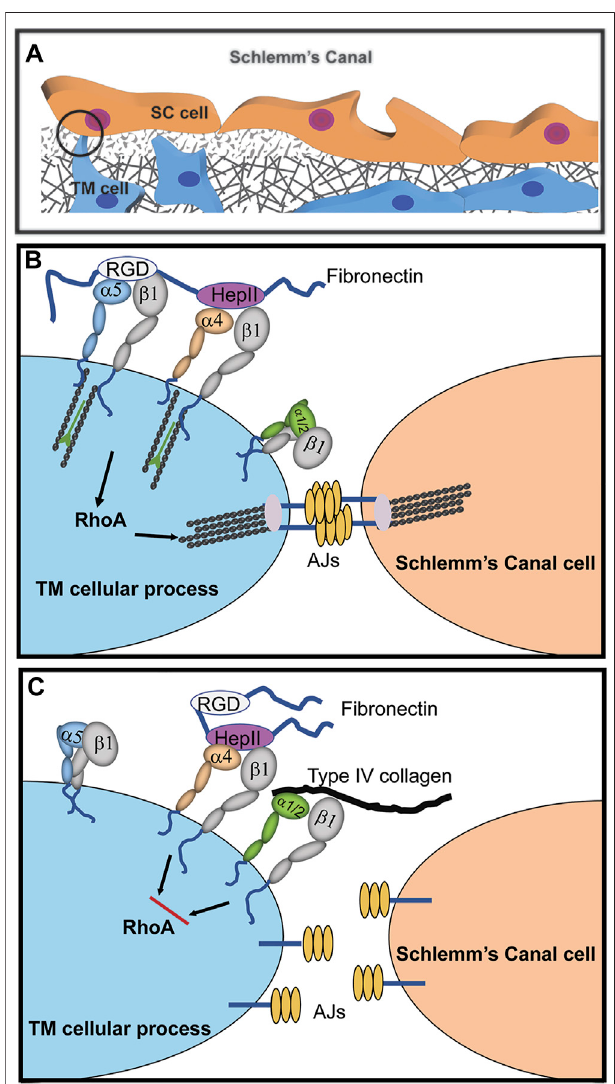
FIGURE 2 | Cooperative signaling with α 4 β 1 integrin controls assembly ofadherensjunctions(AJs). (A) Cadherin-containing AJs arelikelytobefound in the cellular processes connecting juxtacanalicular trabecular meshwork (JCT) and SC cells as well as in cellular processes connecting JCT cells to each other and with JCT cells connected to the cells lining the trabecular beams of the meshwork (Johnstone et al., 2021). (B) Fibronectin in the ECM promotes cooperative signaling between α 4 β 1 and α 5 β 1 integrins that activates RhoA-mediated stress fi ber formation. Crosstalk between this integrinsignalingcomplexandcadherinsinAJsstabilizescell-cellinteractions. (C) The presence of collagen in the ECM binding to either α 1 β 1 or α 2 β 1 integrins disrupts α 4 β 1 integrin signaling with α 5 β 1 integrin. This creates an α 1/ α 2 β 1 and α 4 β 1 integrin complex that inhibits RhoA activity, thus causing a disruption in the formation of stress fi bers and